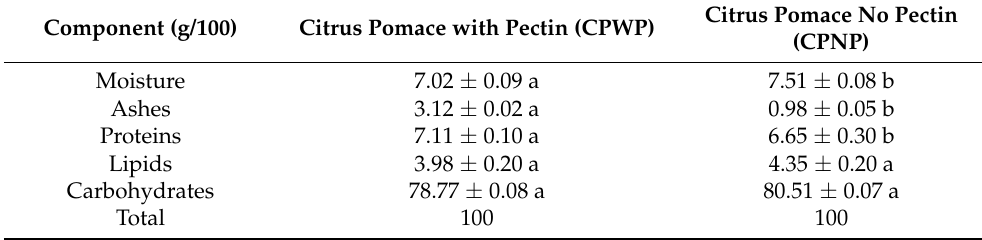
Table 2. Chemical characterization of citrus pomace with and without